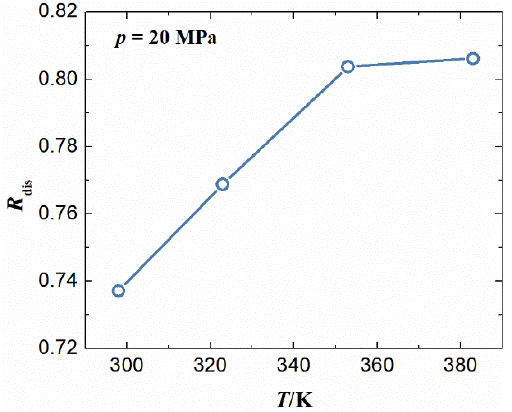
Figure 10. Displacement efficiency of CH 4 by CO 2 as a function of temperature.